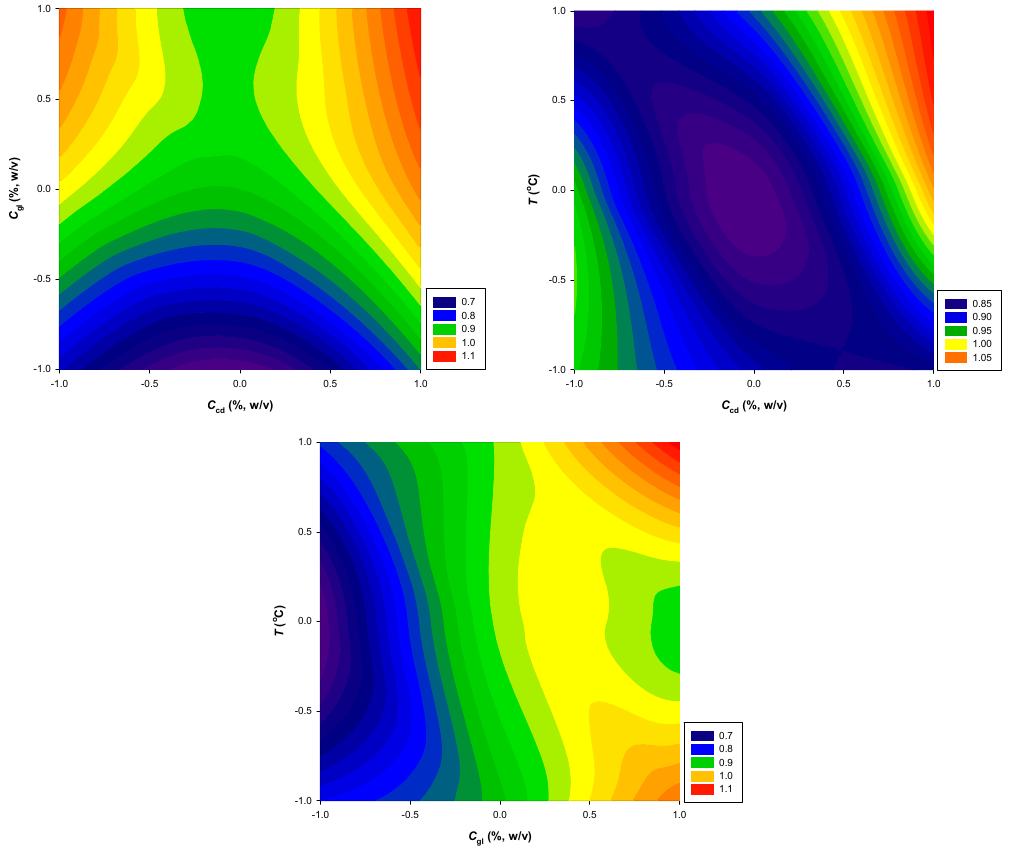
Figure 2. Contour plots illustrating the effect of the independent variables considered on the A AR . The upper left, upper right and lower plots show the effect of simultaneous variation of C gl and C CD , T and C CD and T and C gl , respectively (numbers on the axes correspond to coded values). Extractions of oak acorn husks were carried out under stirring at 600 rpm, for 180 min and a liquid-to-solid ratio of 50 mL·g − 1 .